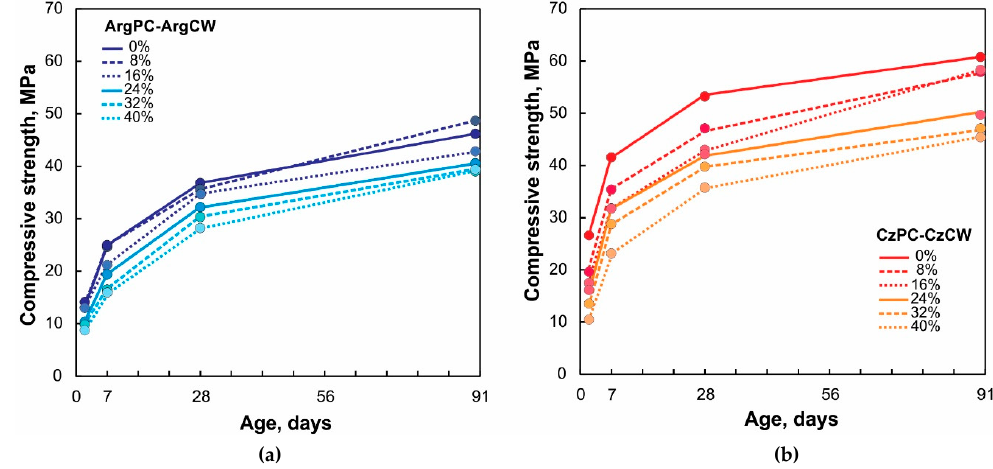
Figure 8. Compressive strength of blended cements: ( a ) ArgCW-ArgPC and ( b ) CzCW-CzPC.